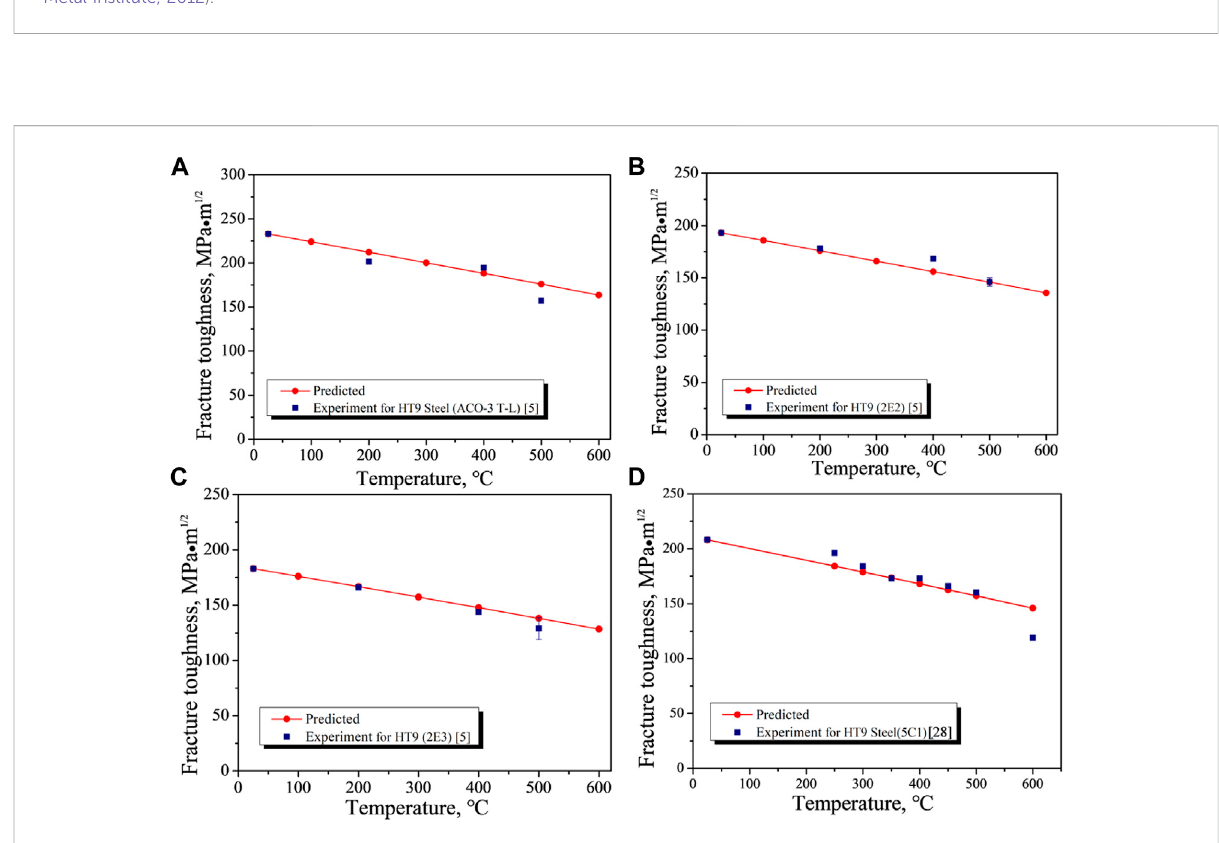
FIGURE 2 Temperature-dependent fracture toughness of HT9 Steel (Byun et al., 2013; Baek et al.,